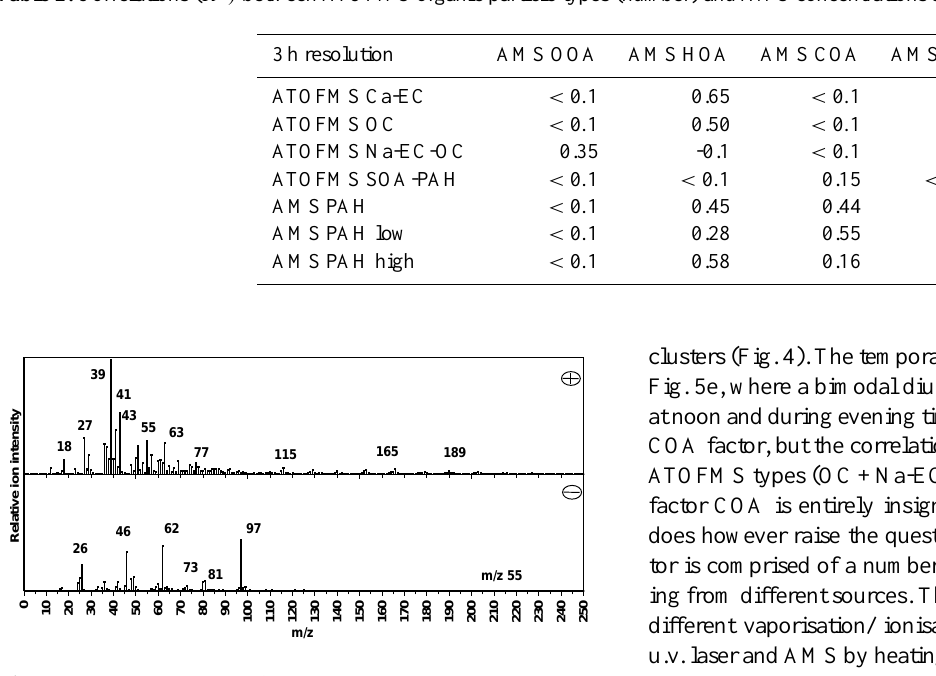
Table 2. Correlations ( R 2 ) between ATOFMS organic particle types (number) and AMS concentrations averaged over 3-h intervals.